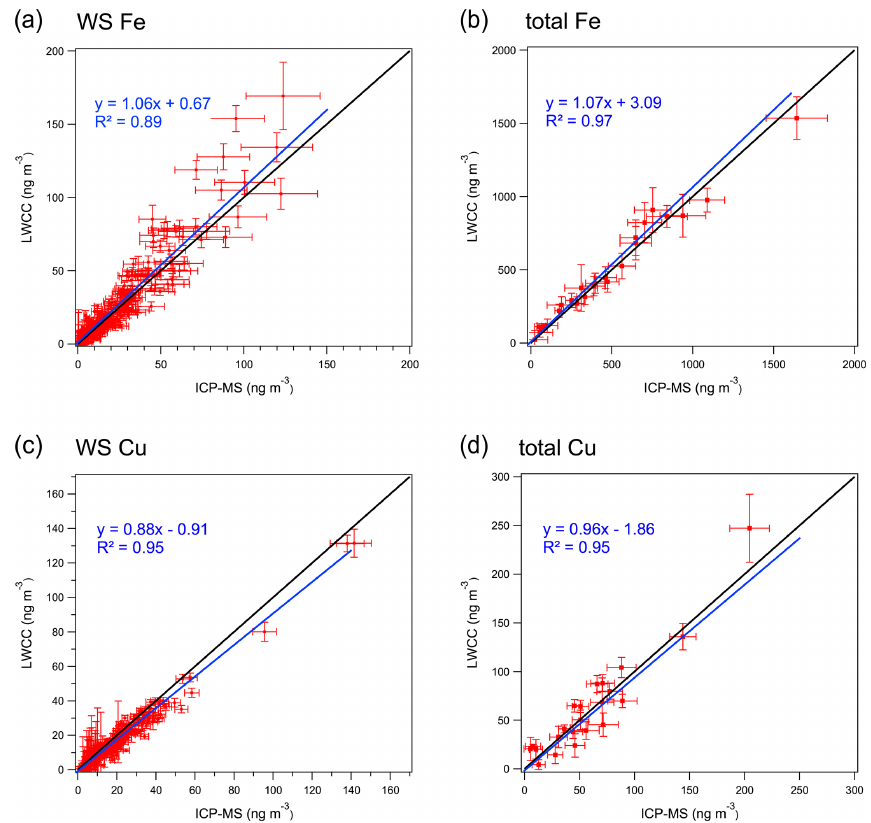
Figure 3. Comparison between LWCC method and ICP-MS method for (a) WS Fe, (b) total Fe, (c) WS Cu and (d) total Cu (results of York regression are shown along with 1 : 1 ratio by the black line). Bars represent the uncertainties in